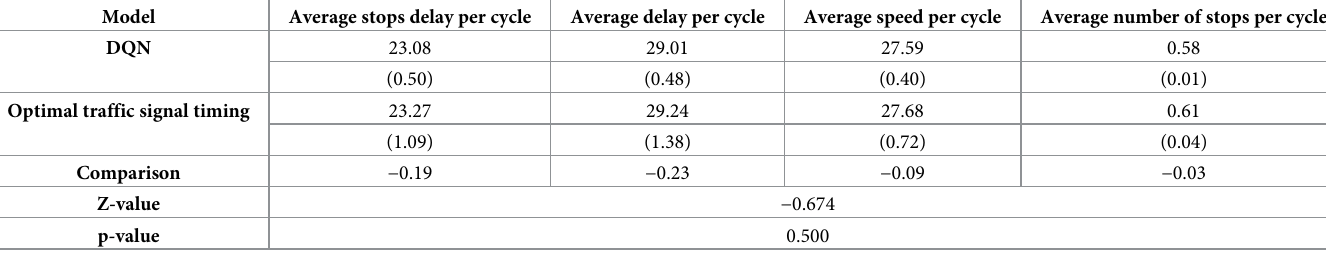
Table 3. Evaluation and validation results of scenario 1–2 in isolated intersection.